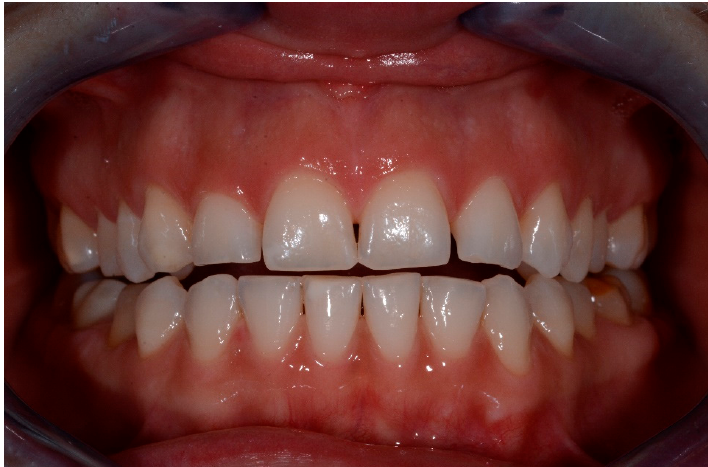
Figure 4. Baseline lesions. Figure 8. t2 lesions.